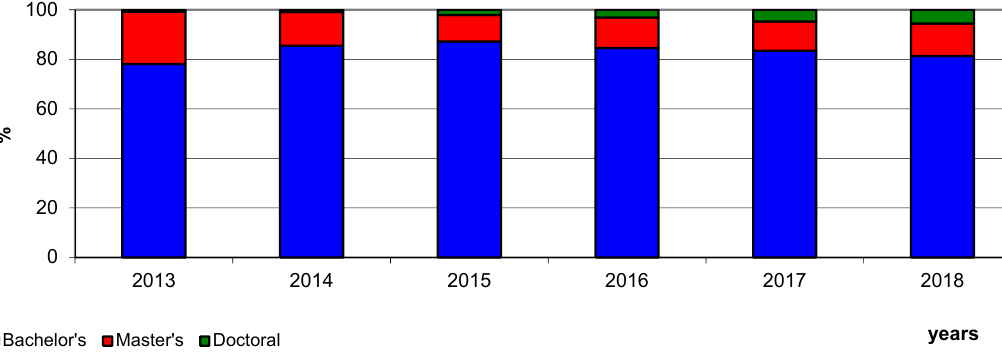
Figure 4. Structure of education in the fields of electricity and energy in Spain in 2013–2018.